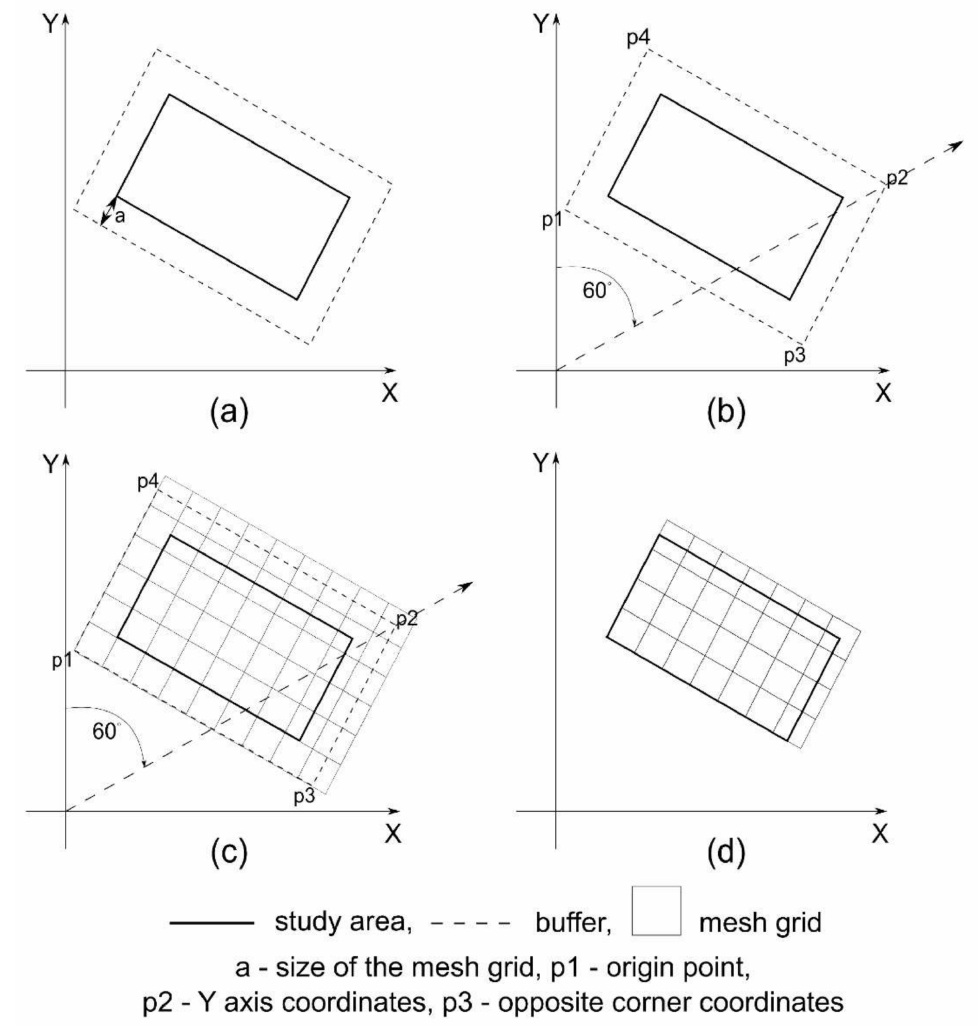
Figure 4. HGIS Fishnet tool workflow stages: ( a ) buffering study area, ( b ) collecting of the four end points of the buffer maximum range coordinates, ( c ) rotation of the grid in accordance with the study area rotation, ( d ) trimming of the grid to the extent of the study